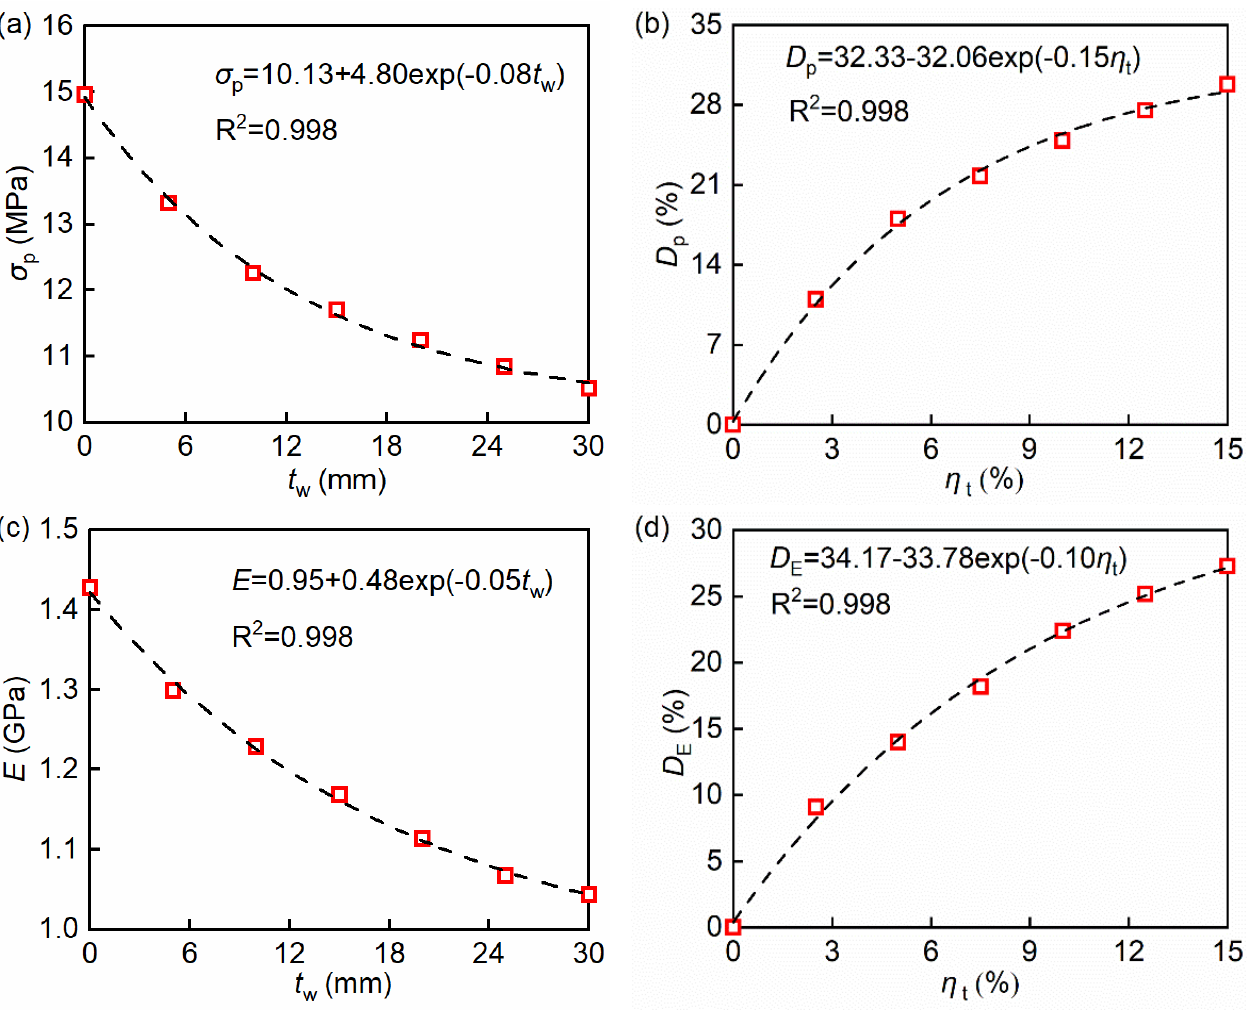
Figure 7. The σ p , E , D p , and D E for weak interlayer with different thicknesses ( a ) peak strength of the samples; ( b ) weakening effect index of weak interlayer on sample peak strength; ( c ) elastic modulus of the samples; ( d ) weakening effect index of weak interlayer on sample elastic modulus.